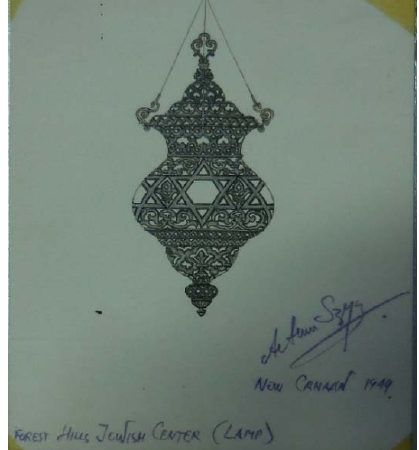
Figure 5. Arthur Szyk, ink sketch for the Ner Tamid, 1949.